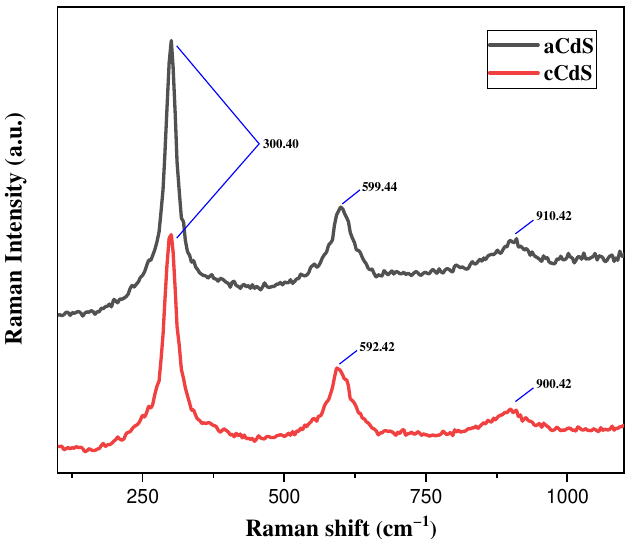
Figure 2. Raman spectra of as-synthesized aCdS and cCdS samples.